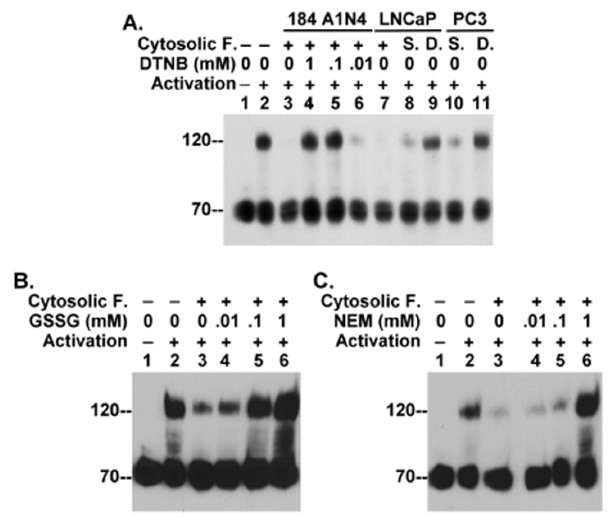
Figure 5. Impact of thio-redox state on matriptase activation. 184 A1N4 cells were homogenized in phosphate buffer pH 6.0 and fractionated to prepare cytosolic and insoluble fractions by centrifuga- tion. ( A ) The insoluble fraction was re-suspended and incubated in phosphate buffer pH 6.0 for 20 min either on ice as a negative control (lane 1) or at room temperature as a positive control (lane 2). The insoluble fraction was also mixed with the cytosolic fraction alone (lane 3) or in the presence of various concentrations of DTNB (lanes 4, 5, and 6). Cytosolic fractions were also prepared from LNCaP and PC3 prostate cancer cells and either dialyzed or stored at 4 u C for three days. The insoluble fraction prepared from 184 A1N4 cells, was incubated with the untreated, stored (S.), or dialyzed (D.) cytosolic fraction from LNCaP human prostate cells (lanes 7, 8, and 9) and PC3 prostate cancer cells (lanes 10 and 11). ( B and C ) The insoluble fraction of 184 A1N4 cells was incubated in phosphate buffer pH 6.0 for 20 min either on ice as a negative control (lane 1) or at room temperature as a positive control (lane 2). The insoluble fraction was also incubated with the cytosolic fraction alone (lane 3) or in the presence of increasing concentrations of oxidized glutathione GSSG ( B , lanes 4, 5, and 6) or NEM ( C , lanes 4, 5, and 6). Lysates were prepared from all incubation conditions and assayed by immunoblot analyses for matriptase activation.